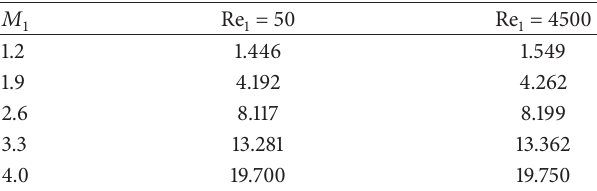
Figure 1: Behaviour of the Re 2 as a function of Re 1 for different values of 𝑀 1 .